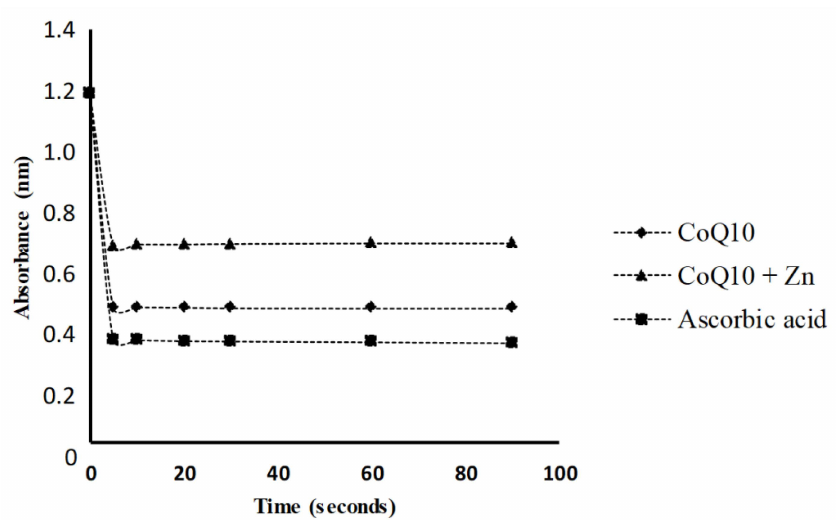
Figure 3. DPPH radical reduction kinetics in the presence of CoQ10 (0.05 mg/mL) and CoQ10 + Zn (0.05 + 0.005 mg/mL, respectively), expressed from a standard ascorbic acid starting point (1 mg/mL).